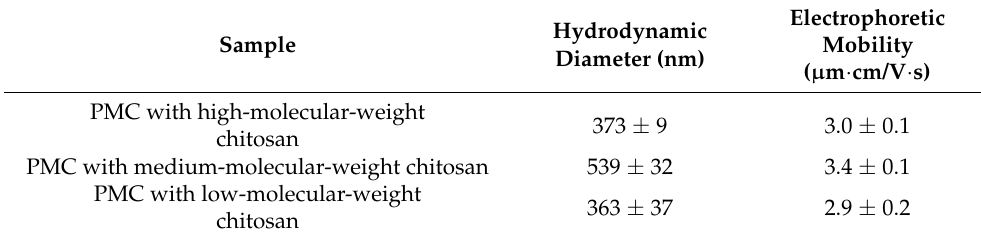
Table 4. Hydrodynamic diameter and electrophoretic mobility of polyelectrolyte–macroion comples (PMC) particles from different molecular weight